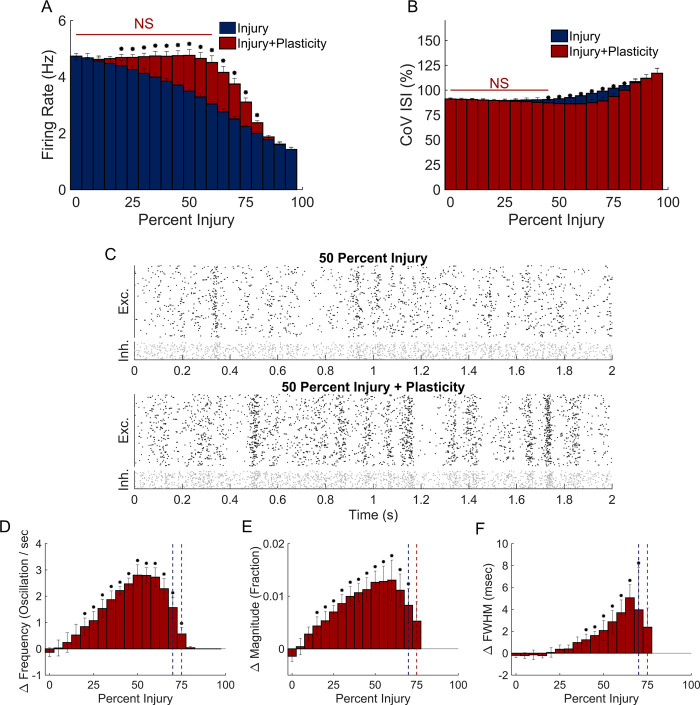
Role of plasticity in network recovery.(A) Four hours of recovery with STDP fully restored neuron activity back to baseline up to 60% damage. (B) With STDP, CoV ISI differed significantly from injury alone in the range of 45–80% damage. (C) Raster plots after 50% neurodegeneration and subsequent STDP recovery. (D,E) Network oscillation frequency and magnitude recovered significantly at moderate levels of damage (two sample t-test with Bonferroni correction for multiple comparisons). These changes were not sufficient to return to baseline, but partially restored function. Dotted vertical line at 70% and 75% injury denote the last injury that all simulations contained oscillations in pre- and post-plasticity simulations, respectively. (F) FWHM changes after plasticity were significantly different from baseline and significantly different from immediately post-injury in the range of 40–70% injury.